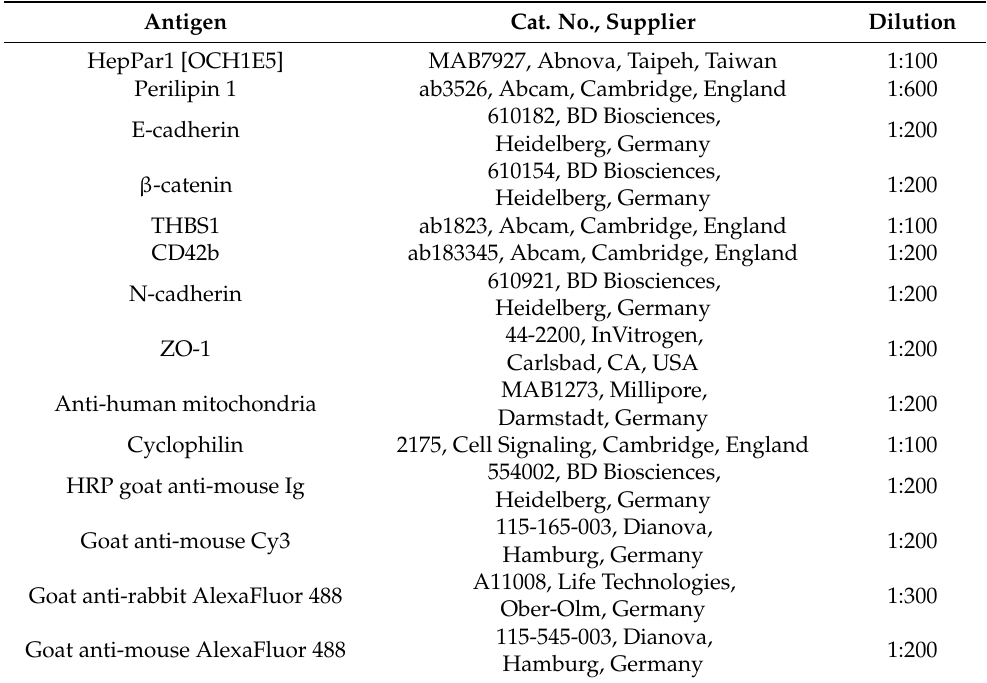
Table 1. List of antibodies used for